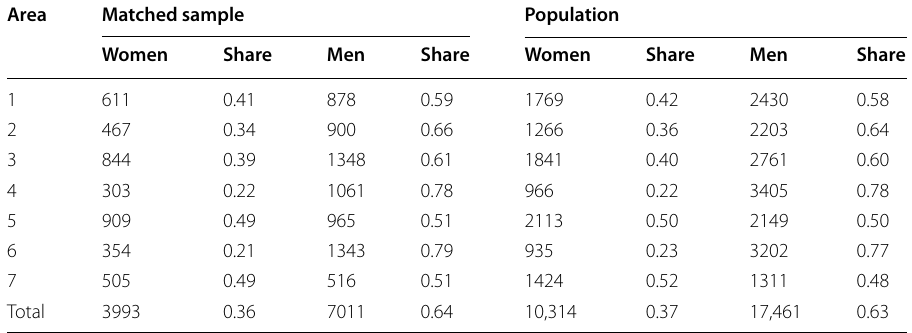
Table 8 Number of women and men in each area: matched sample and population